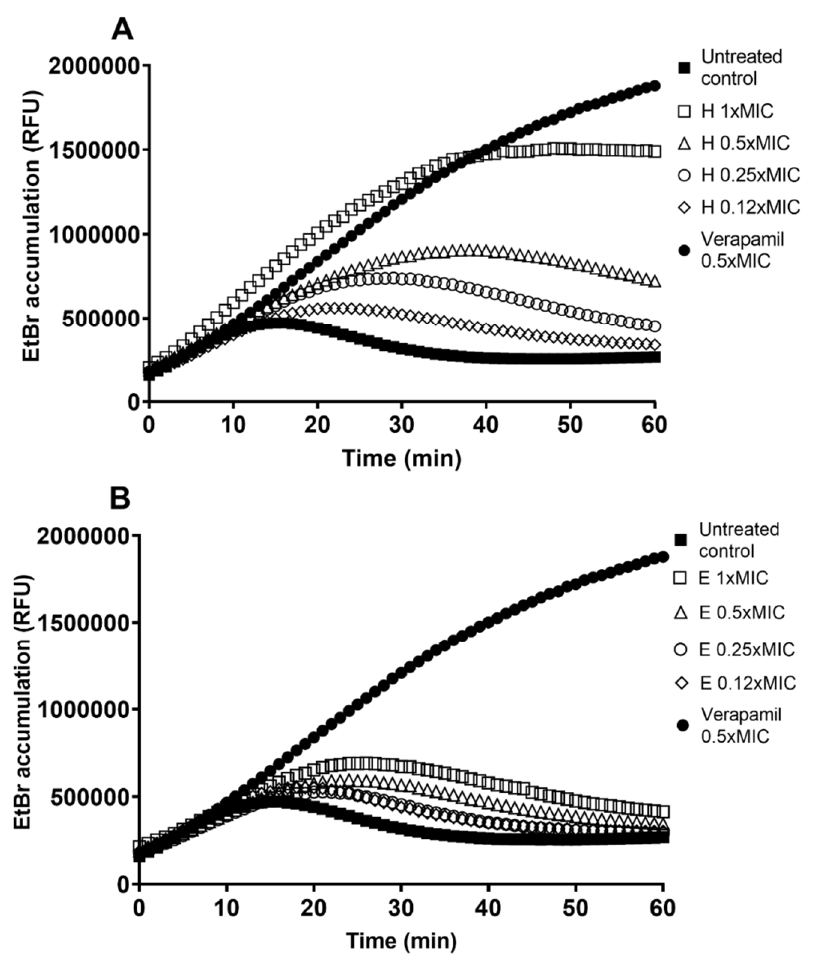
Figure 2. Ethidium bromide (EtBr) accumulation in M. smegmatis mc 2 155 untreated culture (control) and treated with ( A ) the crude hexane (H) and ( B ) ethanol (E) extract at the minimal inhibitory concentration (MIC; 31.35 mg/L), and sub-inhibitory concentrations of 0.5 × MIC (15.62 mg/L), 0.25 × MIC (7.81 mg/L) and 0.12 × MIC (3.91 mg/L), and the known EPI verapamil in 0.5 × MIC (250 mg/L), presented as relative fluorescent units (RFU). A higher fluorescence indicates stronger efflux pump inhibition.